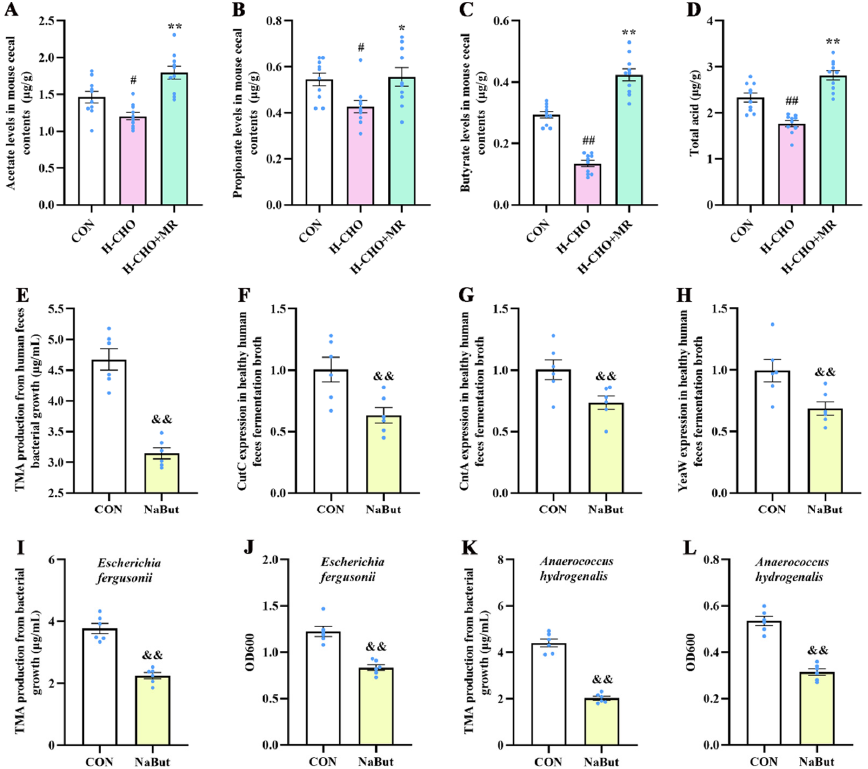
Figure 8. Effects of MR on acetate ( A ), propionate ( B ), butyrate ( C ), and total acid ( D ) levels in the cecal contents of mice fed with the H-CHO diet, and the effects of sodium butyrate supplementation on TMA production by bacteria from human feces ( E ) cultured anaerobically in medium, CutC , CntA , and YeaW expression in healthy human fecal fermentation broth ( F – H ), TMA production from Escherichia fergusonii ATCC 35469 and Anaerococcus hydrogenalis DSM 7454 ( I , K ), and bacteria abundance of Escherichia fergusonii ATCC 35469 and Anaerococcus hydrogenalis DSM 7454 ( J , L ). MR, methionine restriction; TMA, trimethylamine; CutC, CntA, and YeaW, trimethylamine-lyase; NaBut, sodium butyrate; CON, normal diet group; H-CHO, high-choline diet group; H-CHO+MR, high- choline + methionine restricted diet group. # p < 0.05, ## p < 0.01 (H-CHO vs. CON); * p <